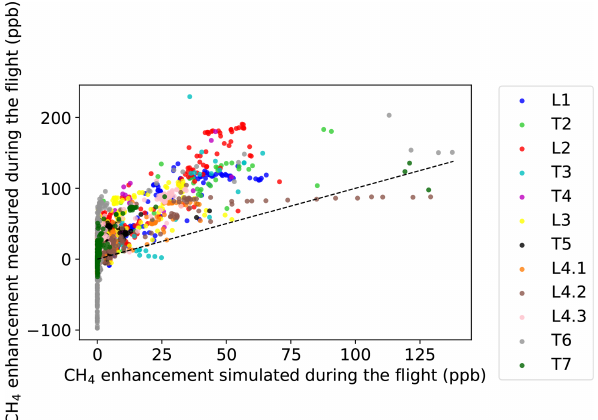
Figure 9. Scatterplots of simulated CH 4 enhancement vs. measured CH 4 for each flight of the campaign except T1 with the 1 : 1 dashed black line. Data were aggregated into 1min bins to produce this